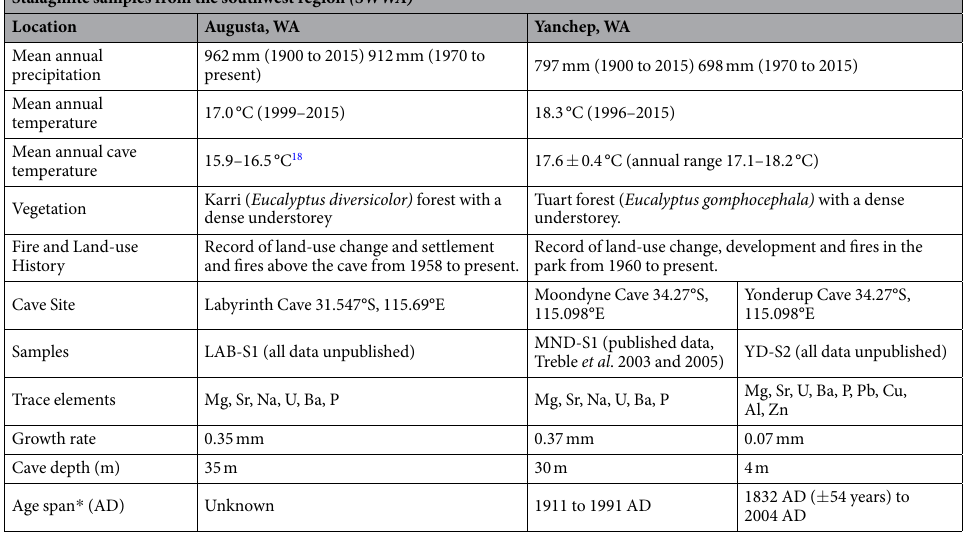
Table 1. Summary of chronology, vegetation, climate and land-use and cave site characteristics for each region/ cave site and stalagmite. Surface temperatures and rainfall data are from Cape Leeuwin (9518) and Gingin (9178) stations 30 . Cave temperature for Yonderup was calculated from 4 hourly measurements from July 2005 to November 2006. ( * ) Age span based on known age constraints for MND-S1 and U-Th dates for YD-S2. See supplementary Table 1 for more detail on U-Th